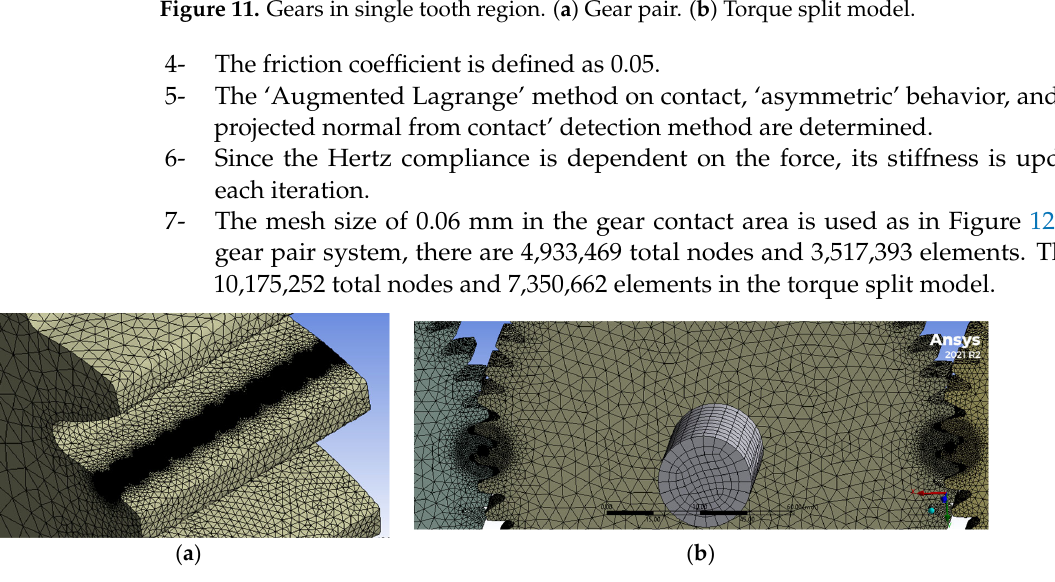
Figure 12. ( a ) Mesh structure on the gear. ( b ) Torque split model contact regions.